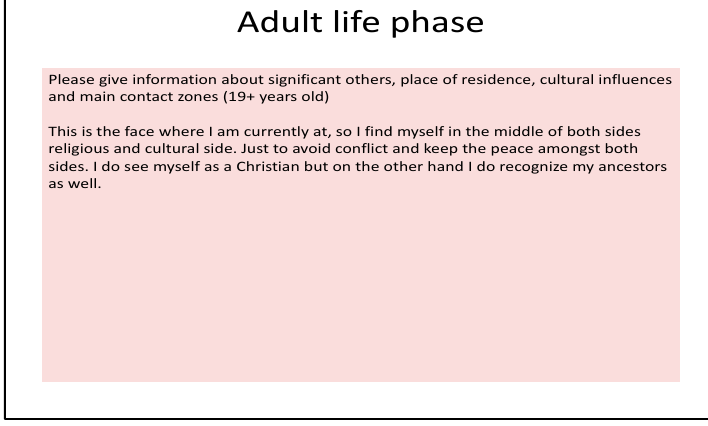
Figure 4. Lihile’s adult life phase.